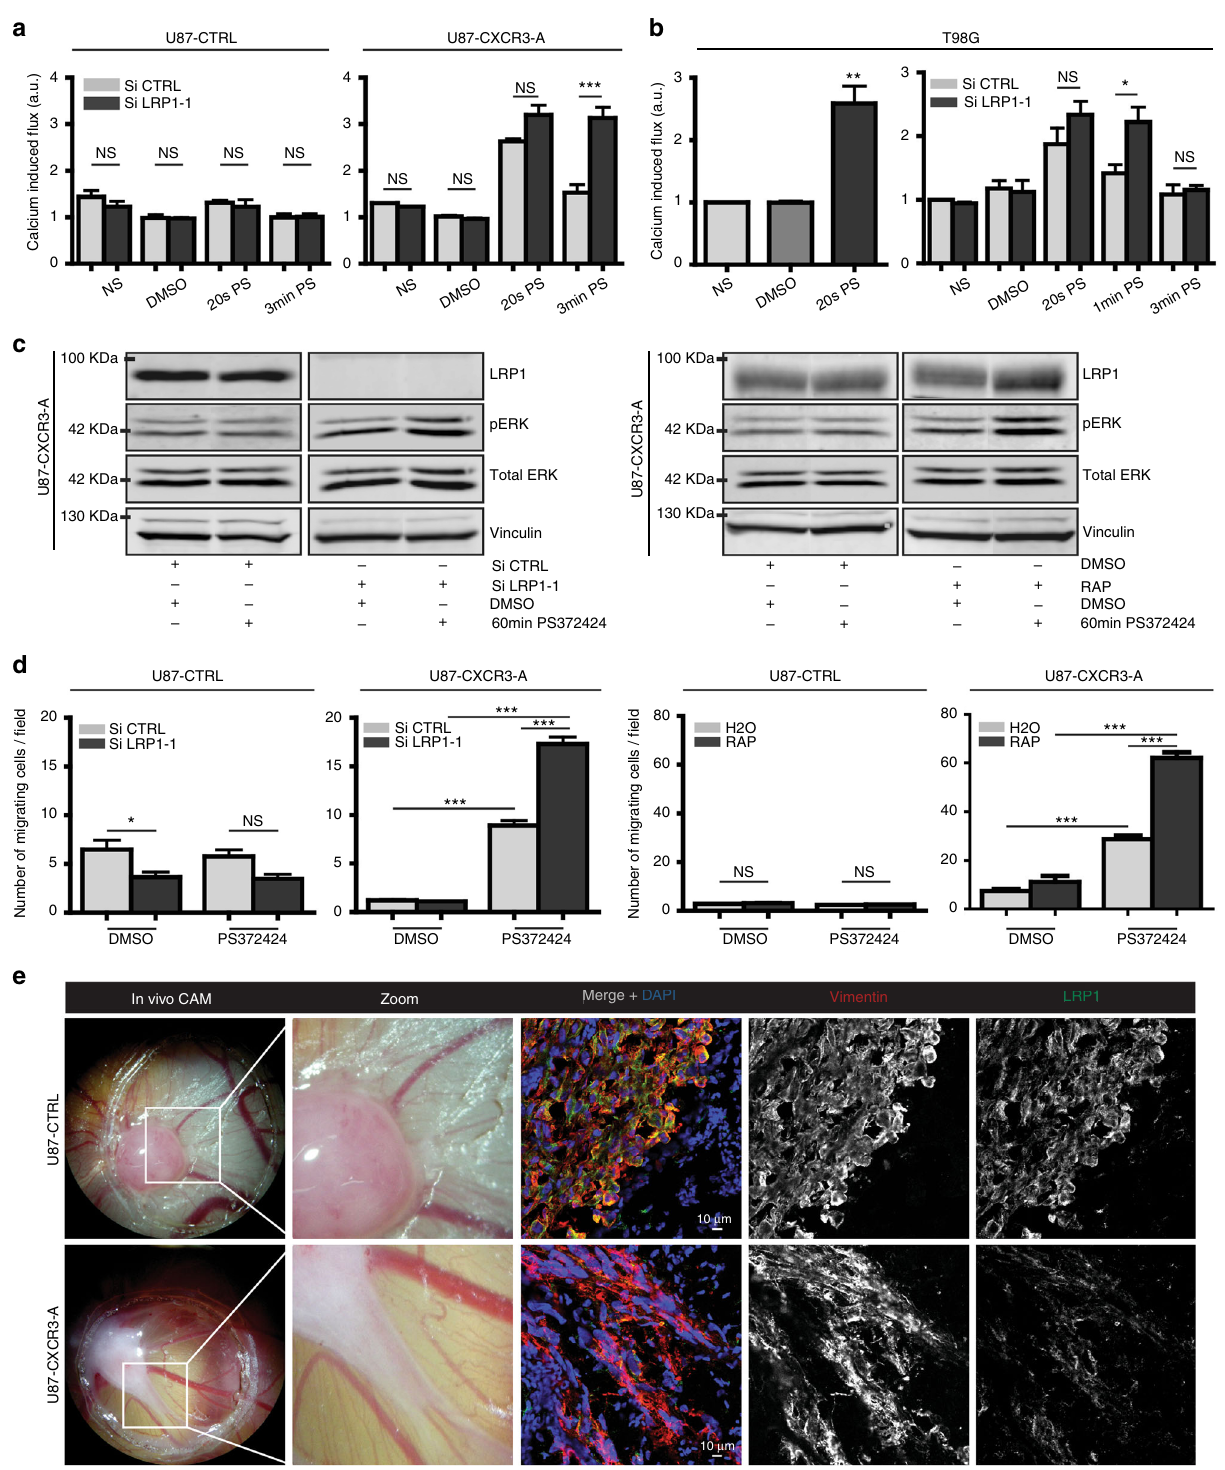
Fig. 8 Role of LRP1 in CXCR3-A activation and function. a Calcium fl ux assessed by FACS analysis in U87-CTRL and U87-CXCR3-A cells after treatment with control SiRNA (Si CTRL) or LRP1 SiRNA (Si LRP1-1). b Calcium fl ux in T98G cells, which express endogenous level of CXCR3-A. NS non-stimulated condition, DMSO negative control, 20 s PS 20 s post stimulation, 3 min PS 3 min post stimulation, a.u. arbitrary unit. *** P < 0.001, ** P < 0.01, * P < 0.05, NS non-signi fi cant. c Western blot for phosphorylated ERK1/2 in U87-CXCR3-A cell extract from Si LRP1-1 or RAP-treated cells after 60 min of stimulation with PS372424. Vinculin and total ERK used as loading controls. d Migration assays ( n = 3) on U87-CTRL or U87-CXCR3-A cells performed after silencing of LRP1 (left panels) or inhibition of LRP1 (RAP, right panels). *** P < 0.001, NS non-signi fi cant. e LRP1 ( λ = 488 nm) and vimentin ( λ = 547 nm) immunostaining were performed at the interface between the CAM and the U87-CTRL or U87-CXCR3-A tumor. Nuclei were stained with DAPI ( λ = 405 nm). Scale: 10 µ m. All the results from three independent experiments were combined to calculate mean and SEM, and values were normalized to those obtained for the control condition. Multiple comparisons were performed with one-way analysis of variance, followed by Bonferroni post hoc